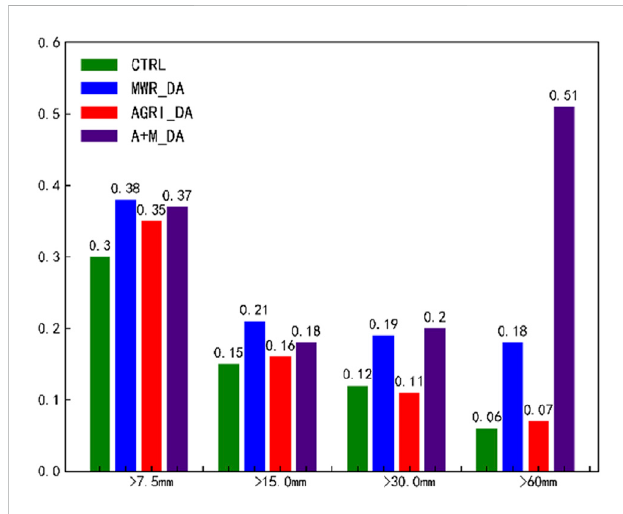
FIGURE 11 TS for 6-h rainfall forecasts from all four experiments at different rainfall thresholds.